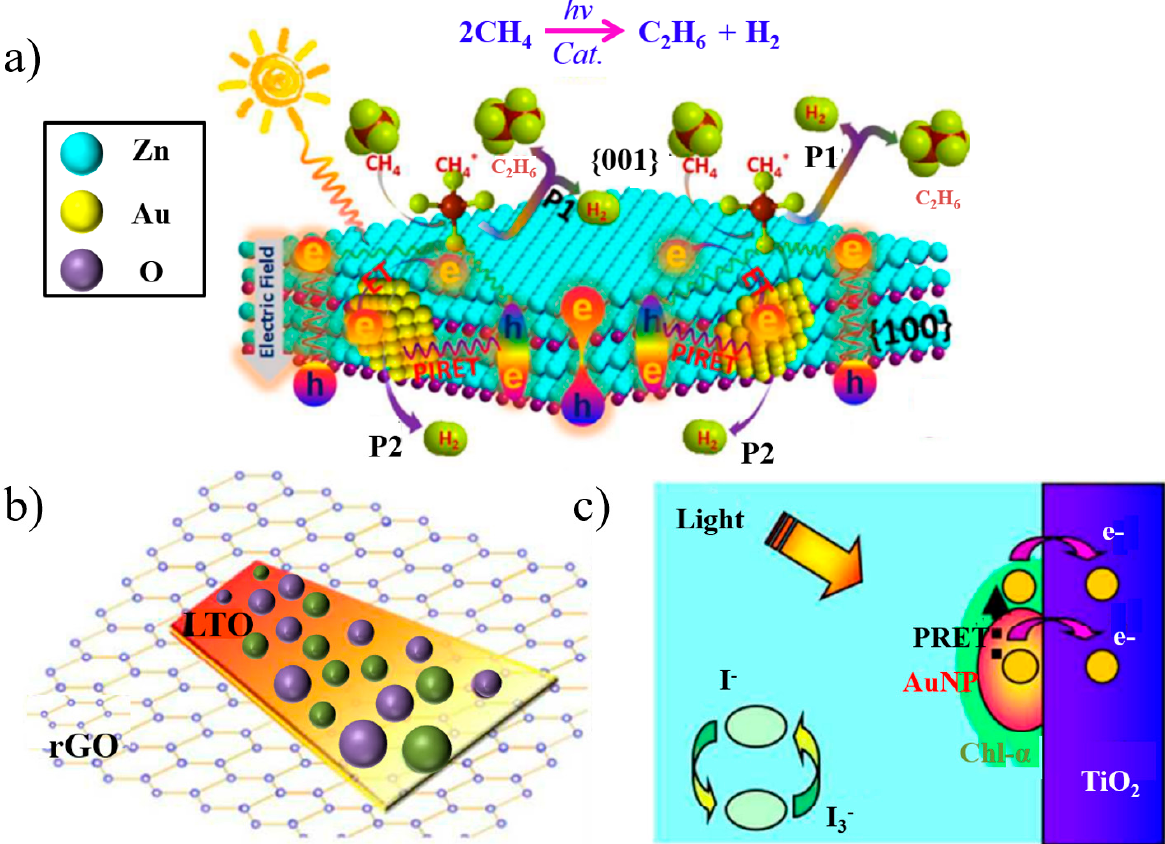
Figure 28. ( a ) Schematic description of idealized photocatalysts. H* is reduced by hot electrons to